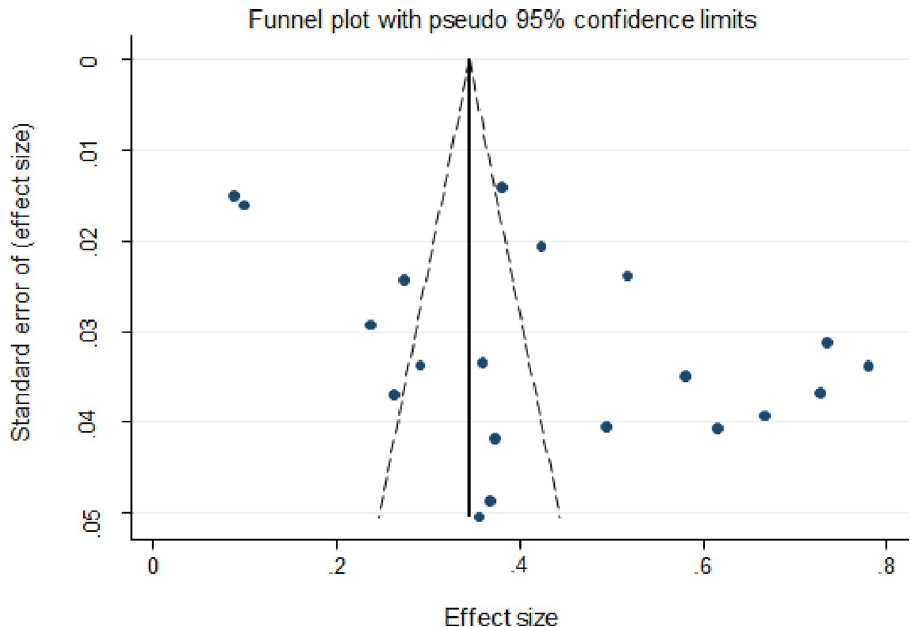
Fig 3. Funnel plot for the pooled proportion of bacteriologically-confirmed EPTB cases amongst all studies identified for review.